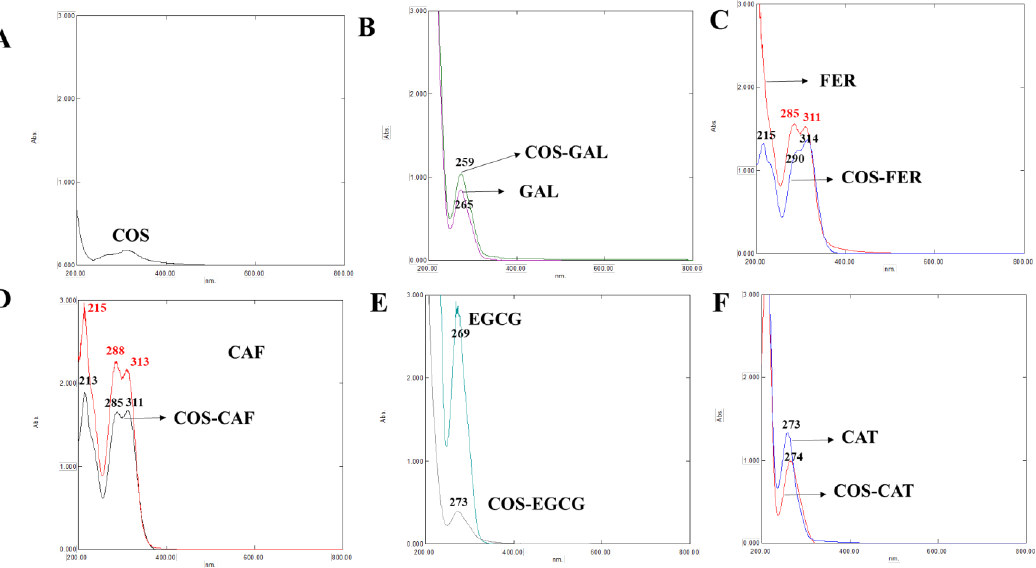
Figure 1. UV spectra of COS ( A ), GAL and COS-GAL ( B ), FER and COS-FER ( C ), CAF and COS-CAF ( D ), EGCG and COS-EGCG ( E ), and CAT and COS-CAT ( F ): COS, chitooligosaccharide; GAL, gallic acid; FER, ferulic acid; CAF, caffeic acid; EGCG, epigallocatechin gallate; CAT, catechin. The black and red numbers on the peaks indicate their wavelength. FTIR spectra of COS-GAL, COS-FER, COS-CAF, COS-CAT, and COS-EGCG in com-